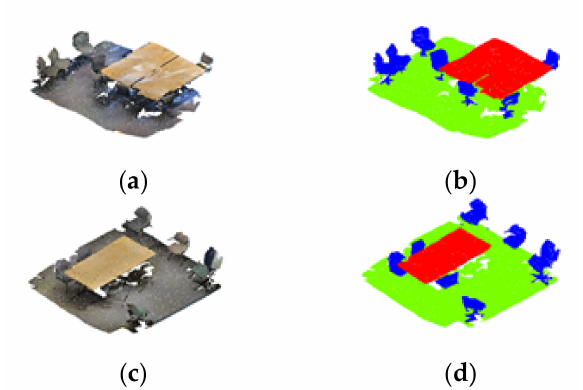
Figure 7. Scene 4 point cloud data. ( a ) Original point cloud of the training set; ( b ) ground truth of the training set; ( c ) original point cloud of the test set; and ( d ) ground truth of the test set. Red, green, and blue points represent the table, floor, and chair, respectively.